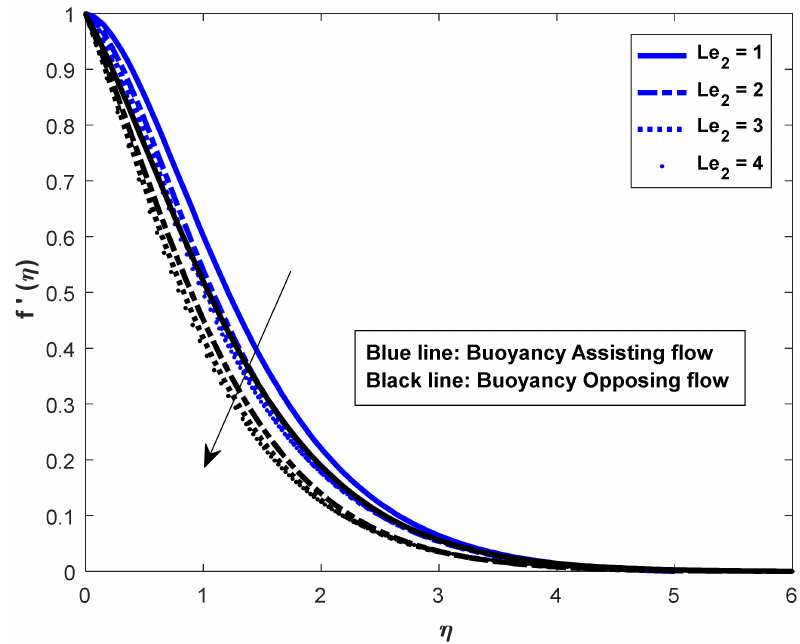
Figure 17. Le 2 on